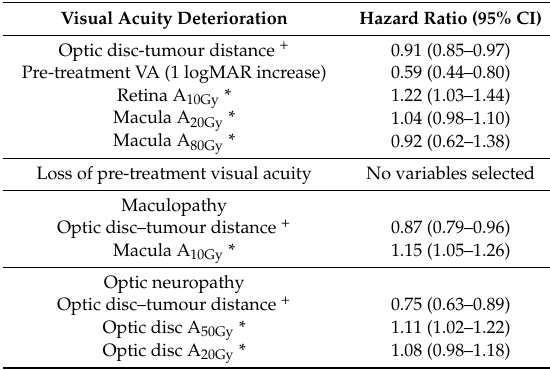
Table 3. Hazard ratios (HR) with 95% confidence intervals (CI) for each of the late complications. logMAR: the logarithm of minimum angle of resolution. VA: Visual acuity.